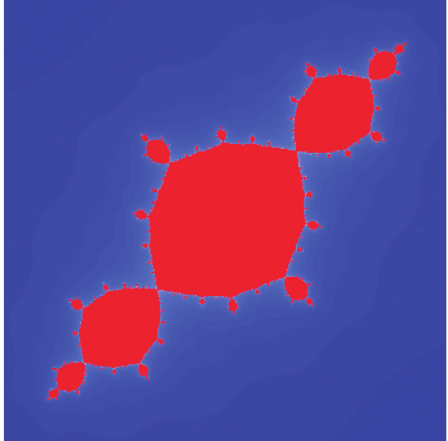
Figure 9: Cubic Julia set in JSOmhh.